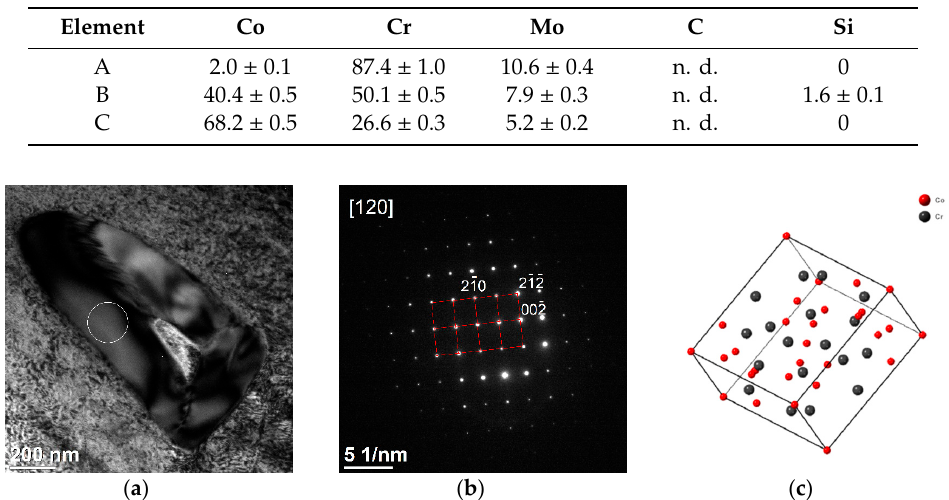
Figure 9. Chemical composition of the precipitates in the Co-PIM sample. ( a ) STEM-HAADF image; ( b ) comparison of EDS spectra at the points indicated in (a); ( c ) maps of Co, Cr, and Mo distribution in the area marked in (a). Table 3. Experimental results (wt.%) of STEM-EDX analysis at the points indicated in Figure 9a. n.d. = not determined.